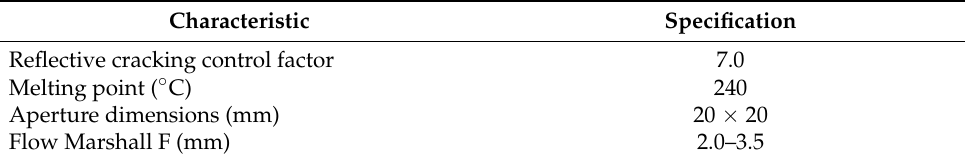
Table 2. Physical characteristics of the geogrid.